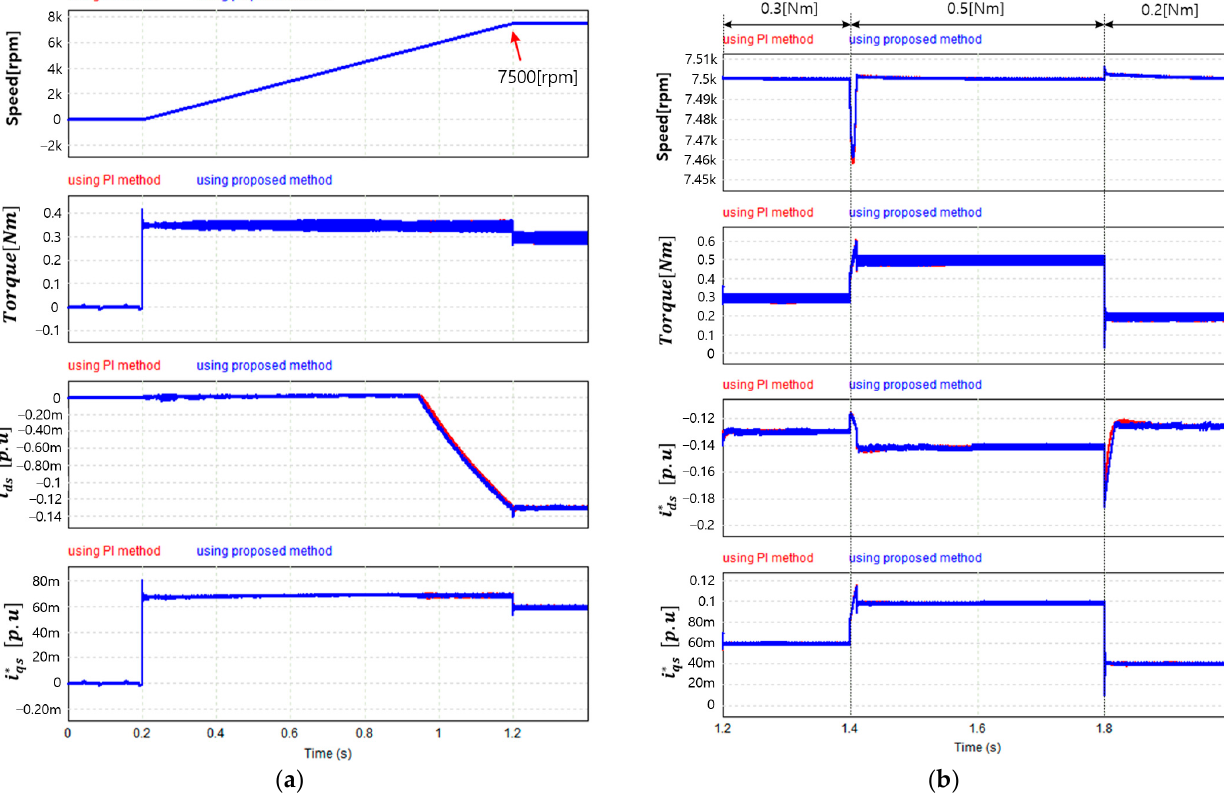
Figure 8. Simulation results according to controller: ( a ) waveform of the process to reach target speed; ( b ) when the torque of the motor changes.